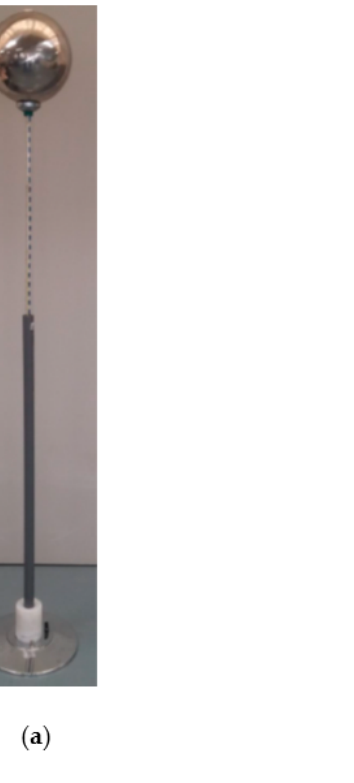
Figure 2. ( a ) High-voltage resistive divider analyzed in this work, ( b ) Main dimensions of the resistive